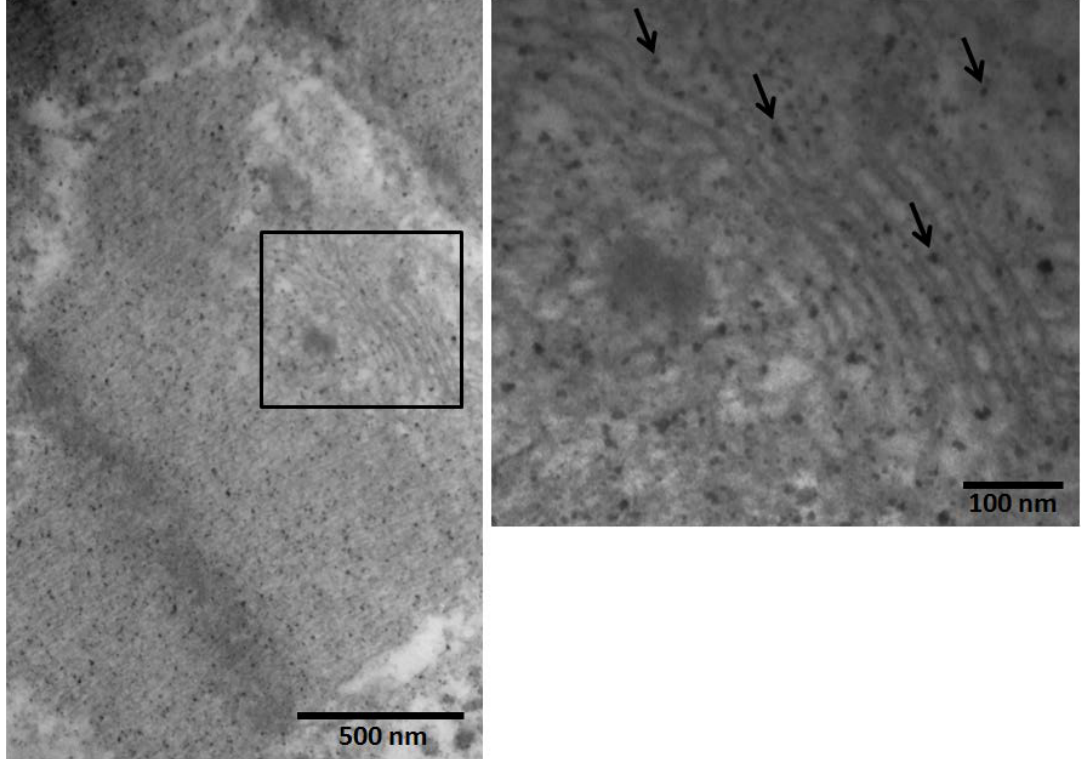
Figure 4. Extensive deposition of nanosized particles was seen in the left ventricular exposed myocardial endoplasmic reticulum of a Mexico City dog (in the inset, arrows point to the nanosized PM in the ER), EM magnifications ×50,000 and 120,000.